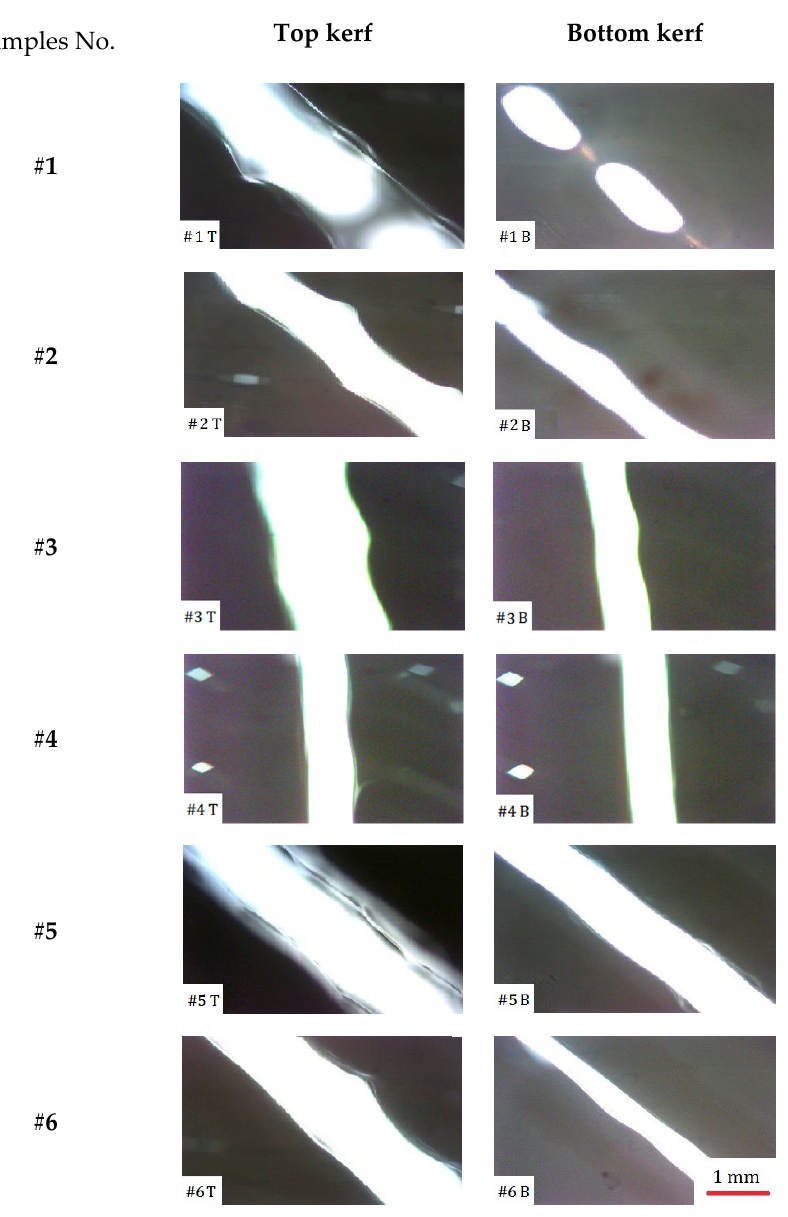
Figure 6. Cutting kerf feature of tests #1–6 .